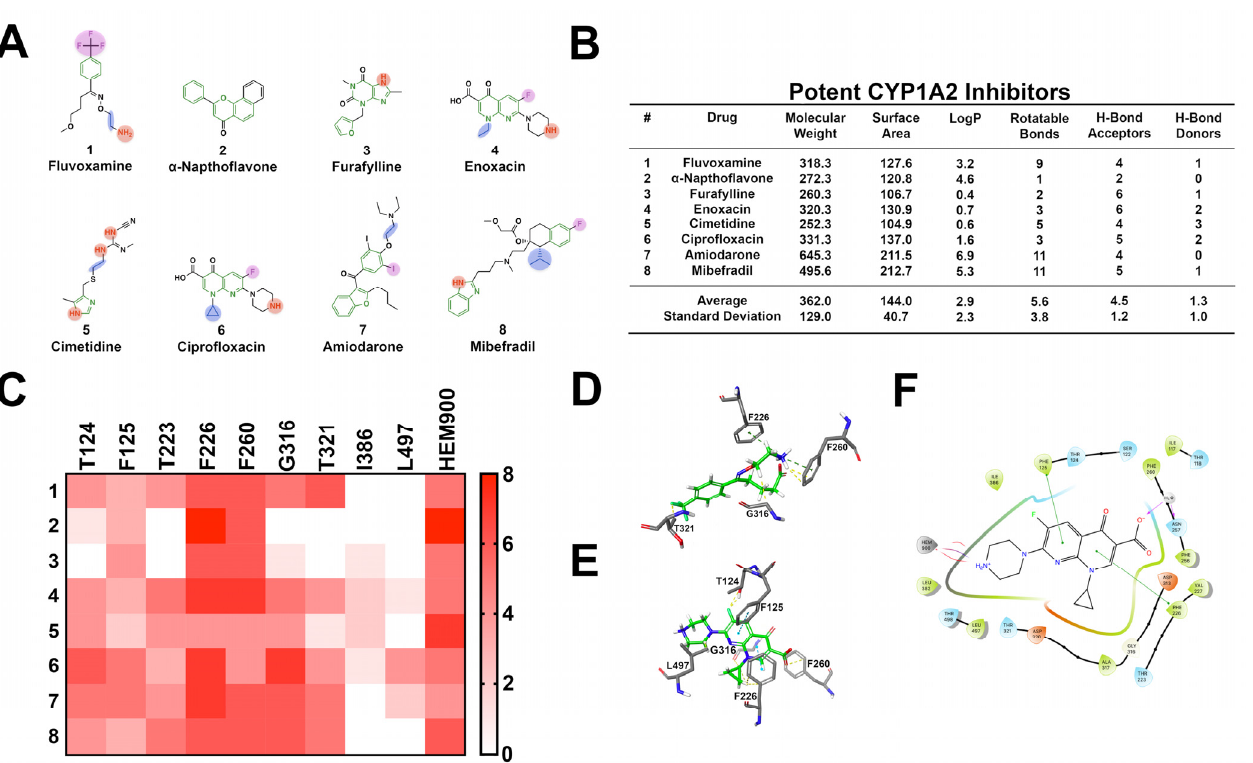
Figure 8. Structural investigation of the 8 most well-characterized high-affinity CYP1A2 inhibitors. ( A ) Common structural features seen in CYP1A2 inhibitors include aromatic rings, heterocycles, primary amines, and halogens. Magenta moieties interact with T124 or T321; green interact with F125, F226, F260, and/or heme; blue interact with G316; red interact with F226, F260 and/or heme. ( B ) CYP1A2 inhibitors are small, planar structures and are moderately flexible with numerous H-bond acceptors. ( C ) Heat map representing the frequency of ligand-to-amino acid binding interactions in the top ten most energetically favorable binding poses in docking against CYP1A2 (PDB ID: 2HI4). Ligand interactions are highly diverse, with key interactions including T124, T223, F226, F260, G316, T321, and heme-900. ( D ) Three-dimensional docking image depicting Fluvoxamine interacting with F226, F260, G316, and T321. ( E ) Three-dimensional docking image portraying ciprofloxacin interacting with T124, F125, F226, F260, G316, and L497. ( F ) Two-dimensional ligand interaction map depicting ciprofloxacin interacting with F125 and F226, while coordinating with heme-900.